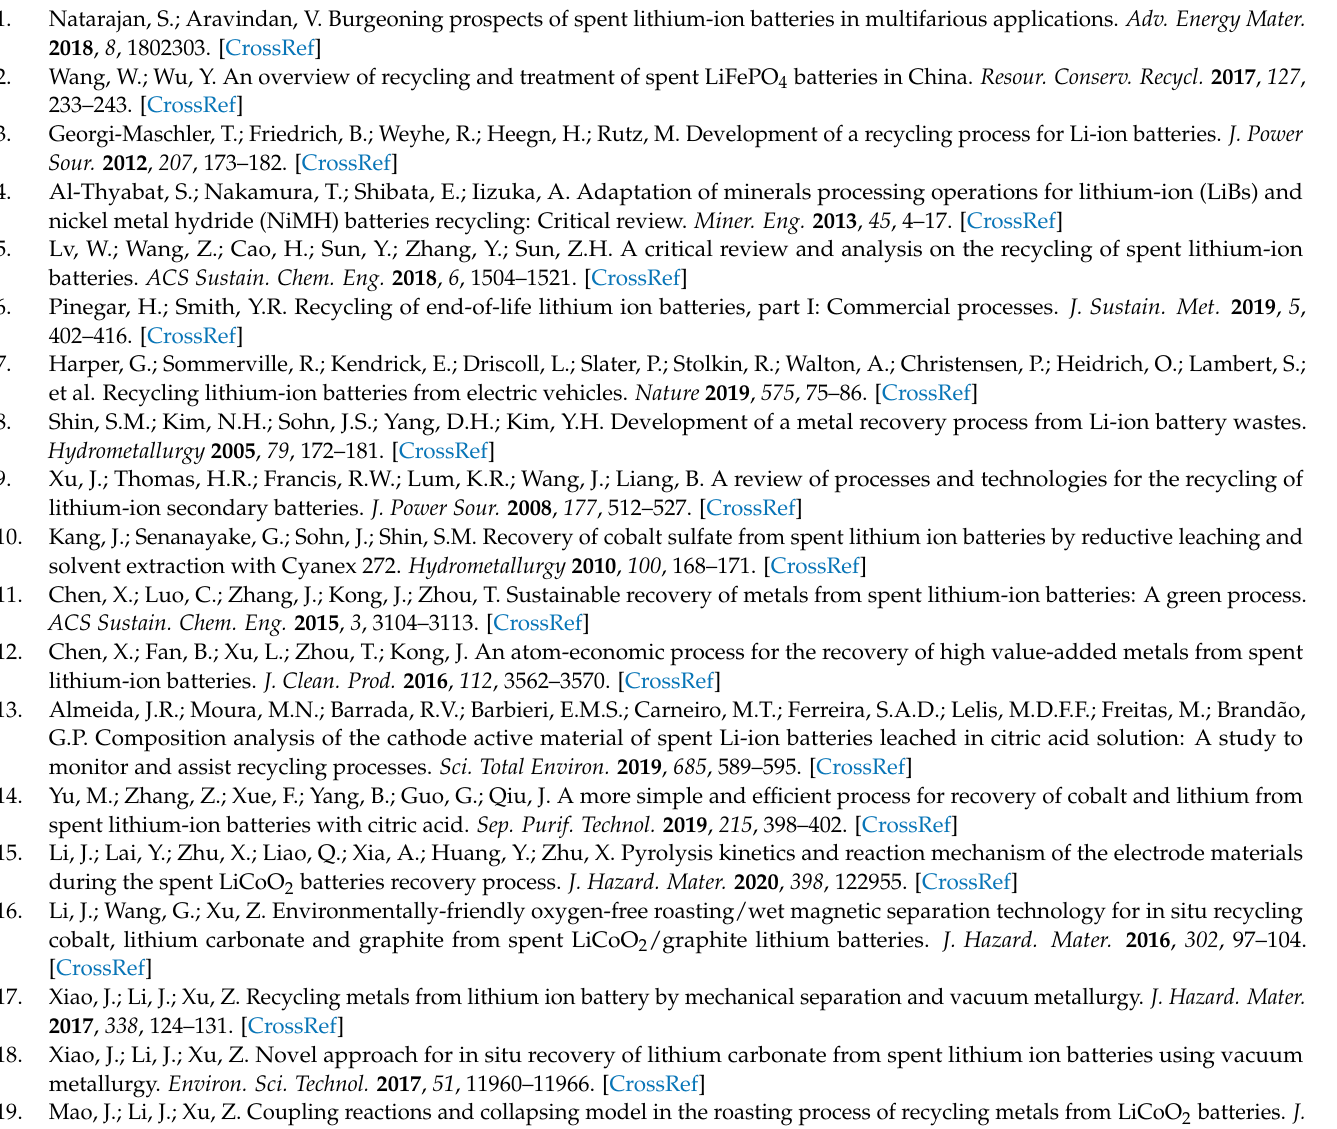
for EV LIBs. Table S3: Carbon-containing components in lithium-ion battery cells and their carbon contents. Table S4: Energy consumption and GJG emissions associated with chemicals used in LIB recycling. Table S5: GHG emissions associated with different electricity structure. Table S6: Sulfuric acid leaching conditions for recycling of valuable metals from LIBs. Table S7: Citric acid leaching conditions for recycling of valuable metals from